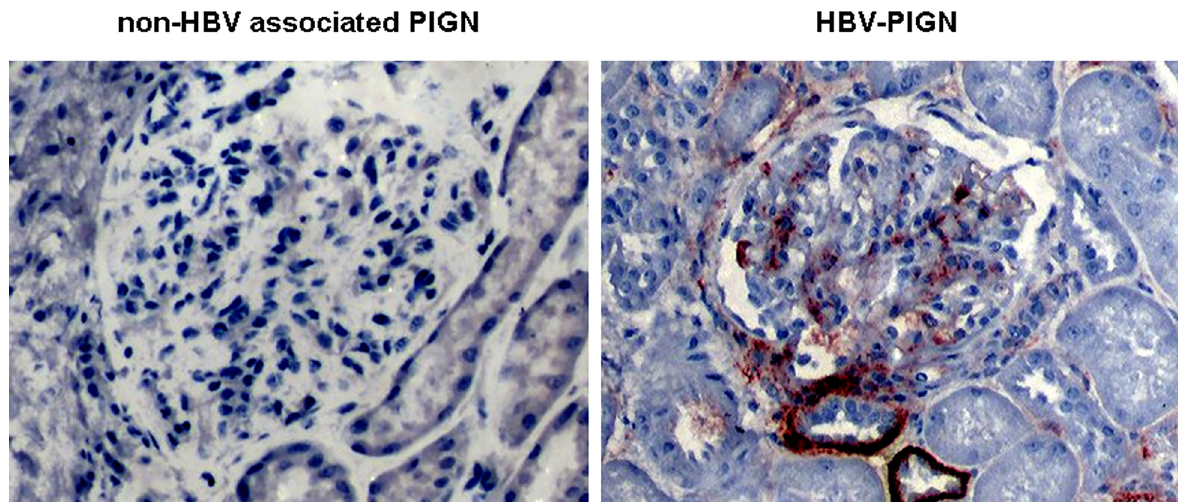
Fig 2. The presence of HBsAg in glomeruli of HBV-PIGN: HbsAg immunostaining was performed with a specific antibody and visualized by the immunoperoxidase method. Representative pictures show dark red positive stains in glomerulus and in the basal membrane of tubules in HBV-PIGN. The stains are negative in non-HBV associated PIGN.